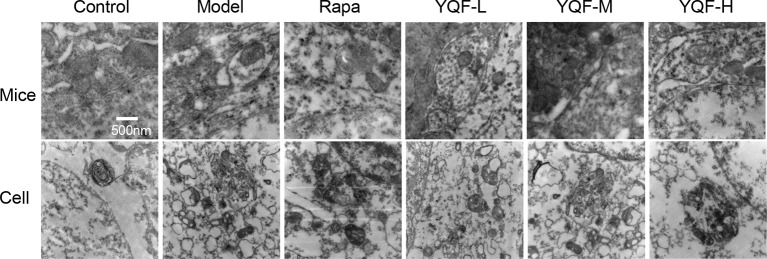
Ultrastructure of hippocampus of 9-month-old APP/PS1 transgenic mice, C57BL/6J mice, HEK293 cells, and APP/PS1 HEK293 cells. Autophagy vesicles were detected by transmission electron microscope after the treatment of rapamycin and YQF (500nm).